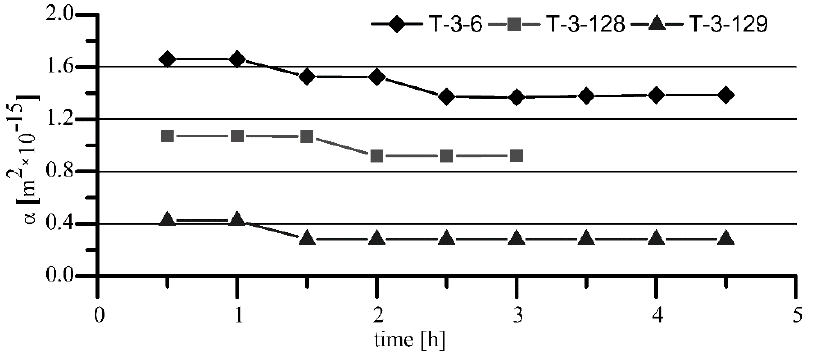
Figure 5. Oil permeability of T-3-x sleeves with addition of BN for Hipol 15F (O-3) oil.